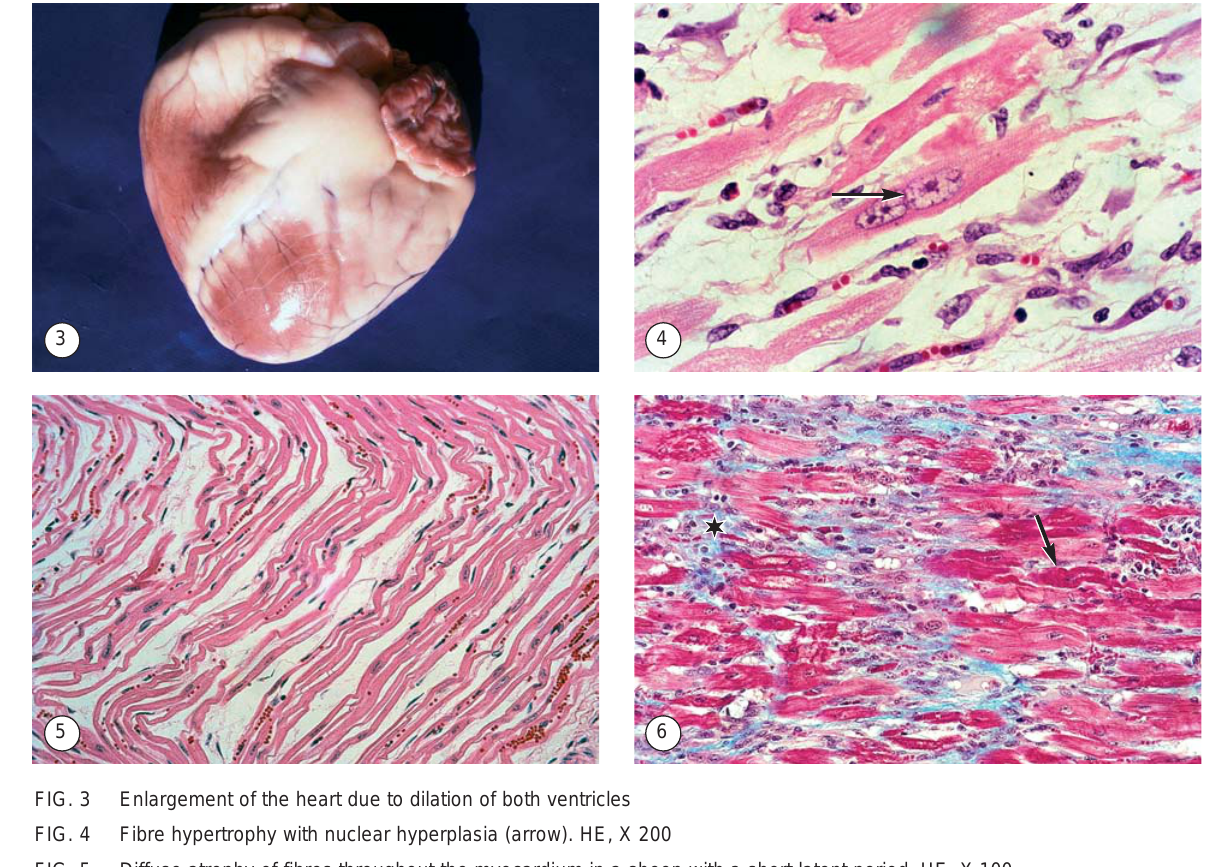
FIG. 3 Enlargement of the heart due to dilation of both ventricles FIG. 4 Fibre hypertrophy with nuclear hyperplasia (arrow). HE, X 200 FIG. 5 Diffuse atrophy of fibres throughout the myocardium in a sheep with a short latent period. HE, X 100 FIG. 6 Multifocal necrosis (arrow) with replacement fibrosis (star). Masson’s trichrome